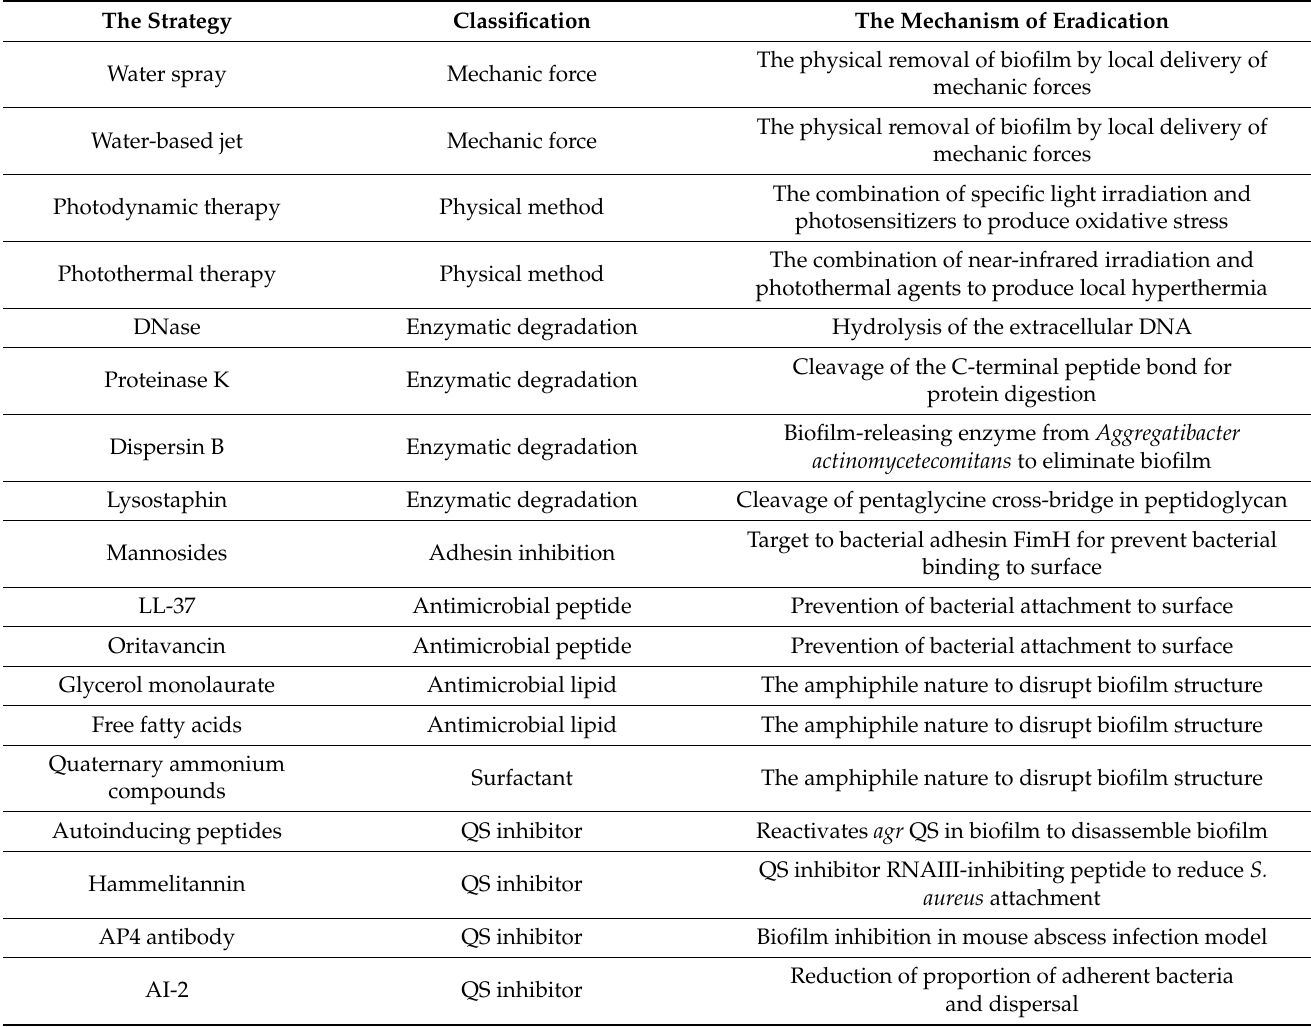
Table 1. The treatment strategies of biofilm